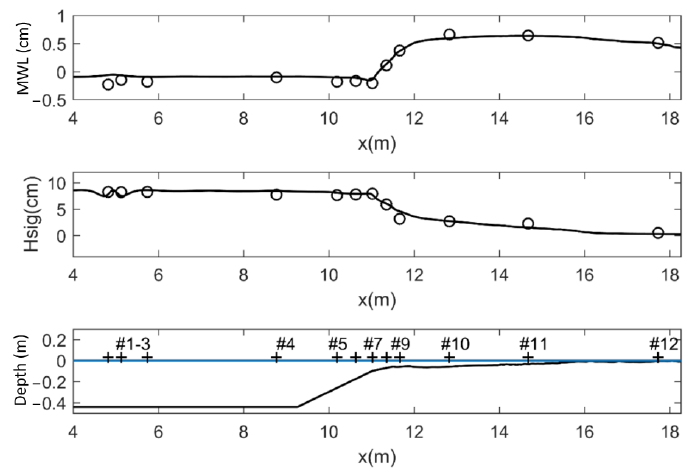
Figure 7. Variation of the significant wave height and mean water level over the reef profile for Case 278. Solid line: predictions by present model; open circles: laboratory measurements. Water 2018 , 10 , 1147